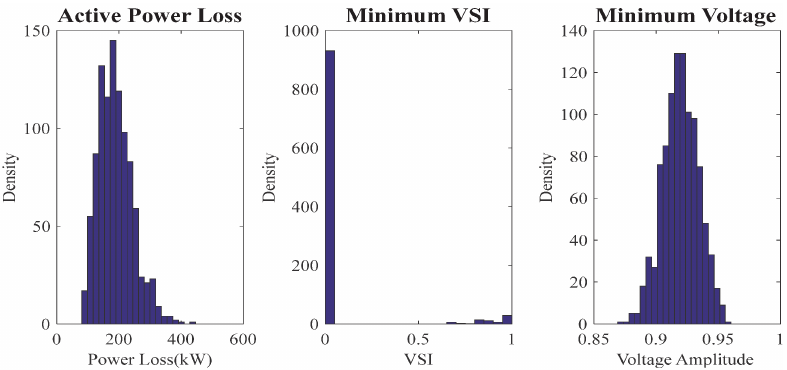
Figure 12. Stochastic evaluation of the 69-bus system with uncertainties before placement of